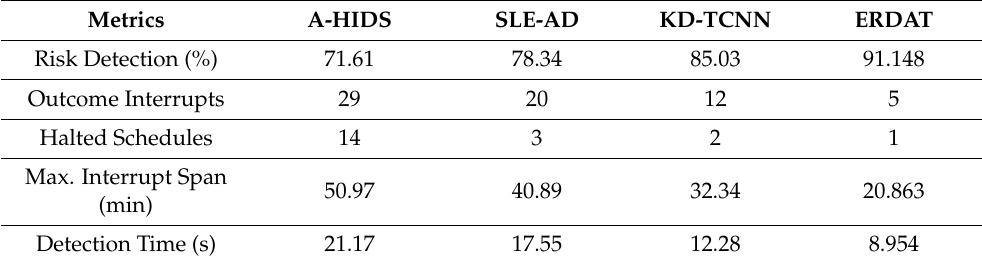
Table 4. Comparative Analysis of Interrupts.